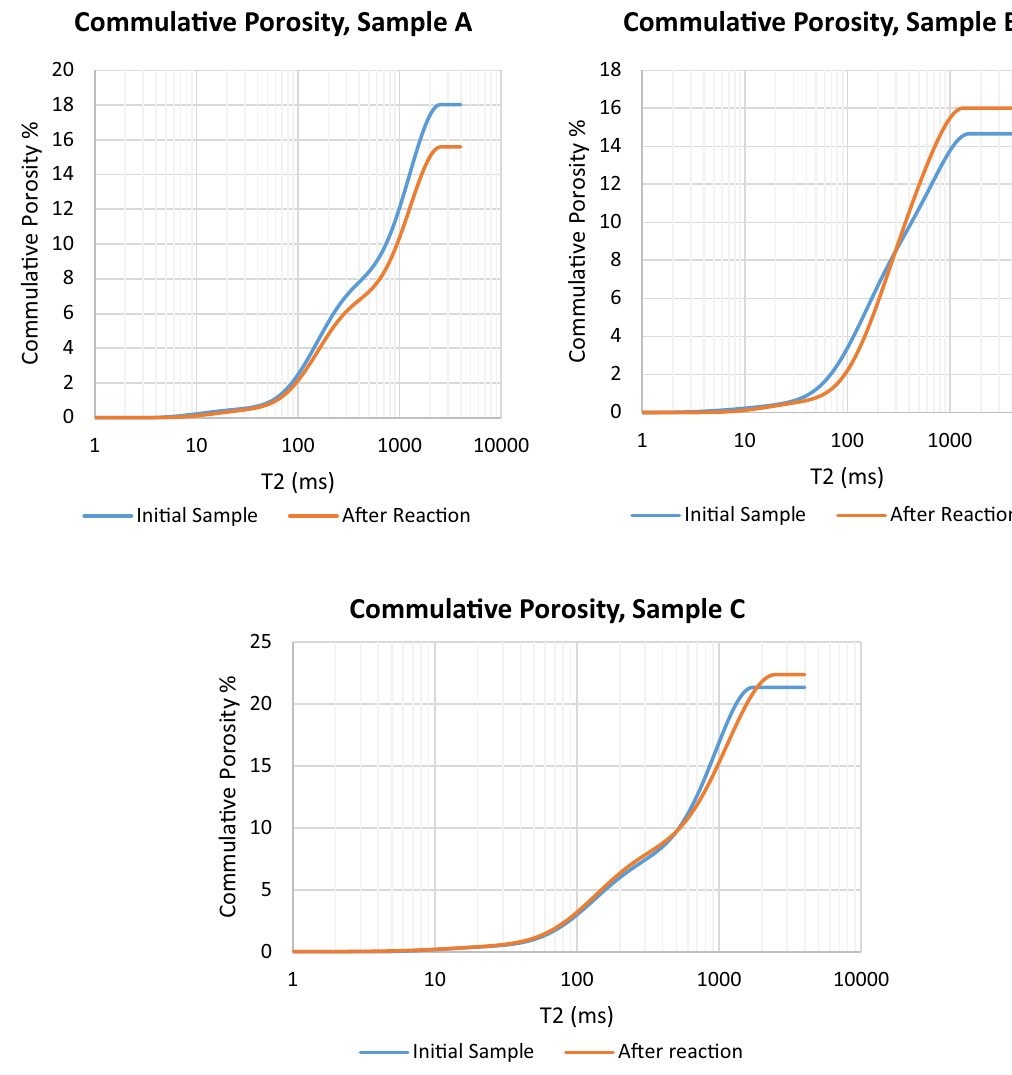
Fig. 14 T2 commulative spectrum of all Guelph dolomite core samples before and after reaction with